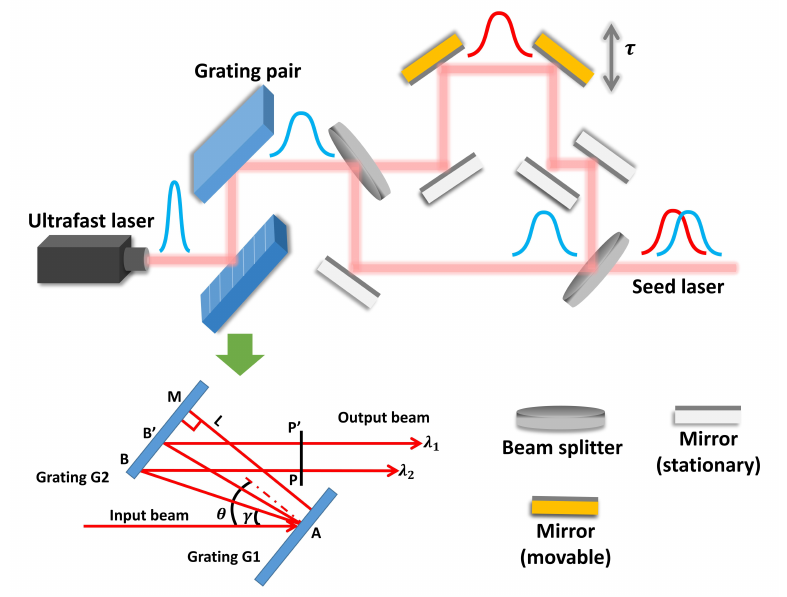
Figure 1. The layout of the frequency beating laser system in the proposed